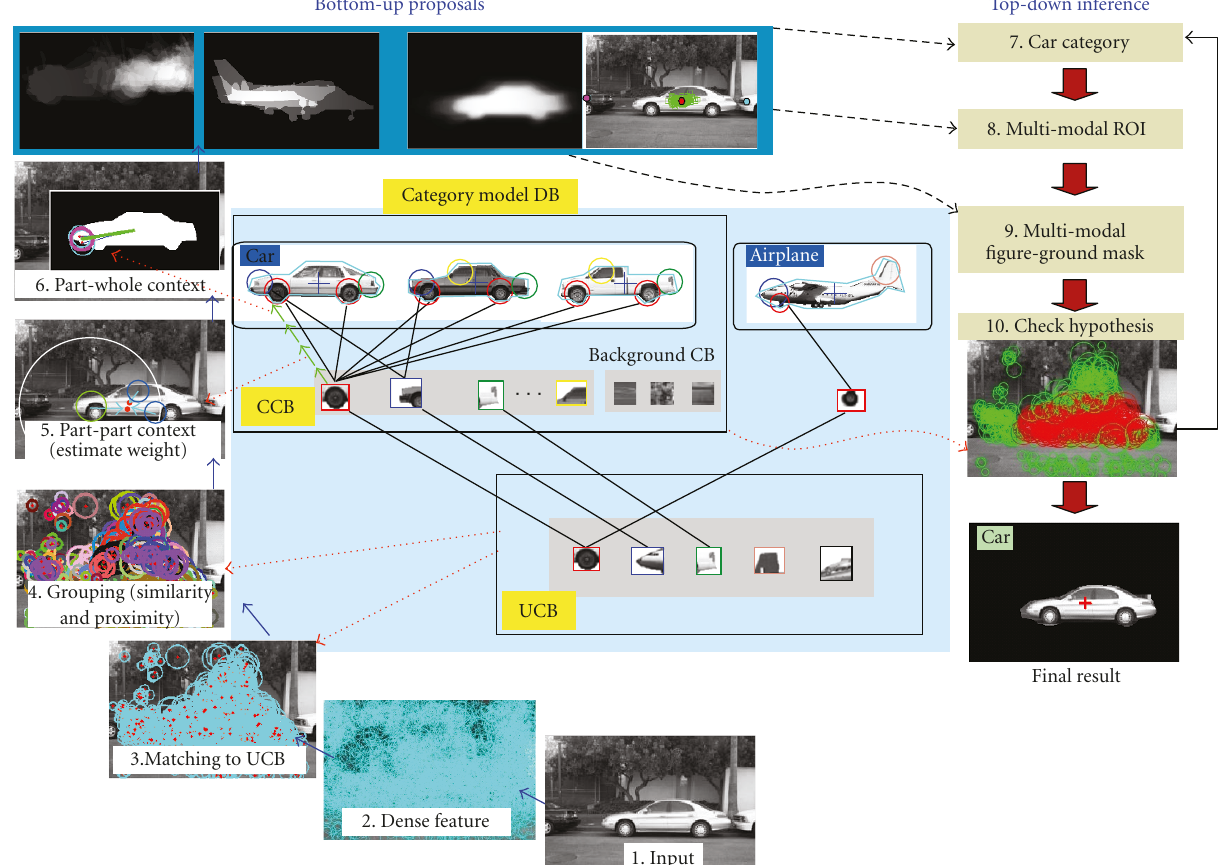
Figure 21: The overall inference flow by boosted MCMC method for simultaneous object categorization and figure-ground segmentation.